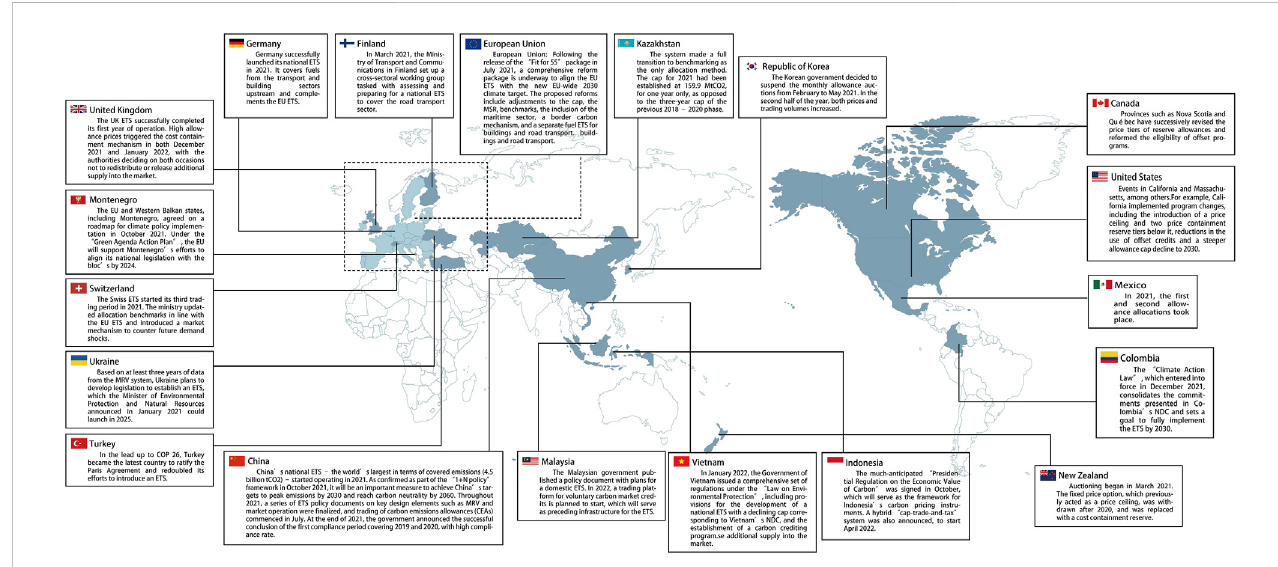
FIGURE 1 Distribution of Emissions Trading Systems around the world Source from: ICAP Status Report 2022.